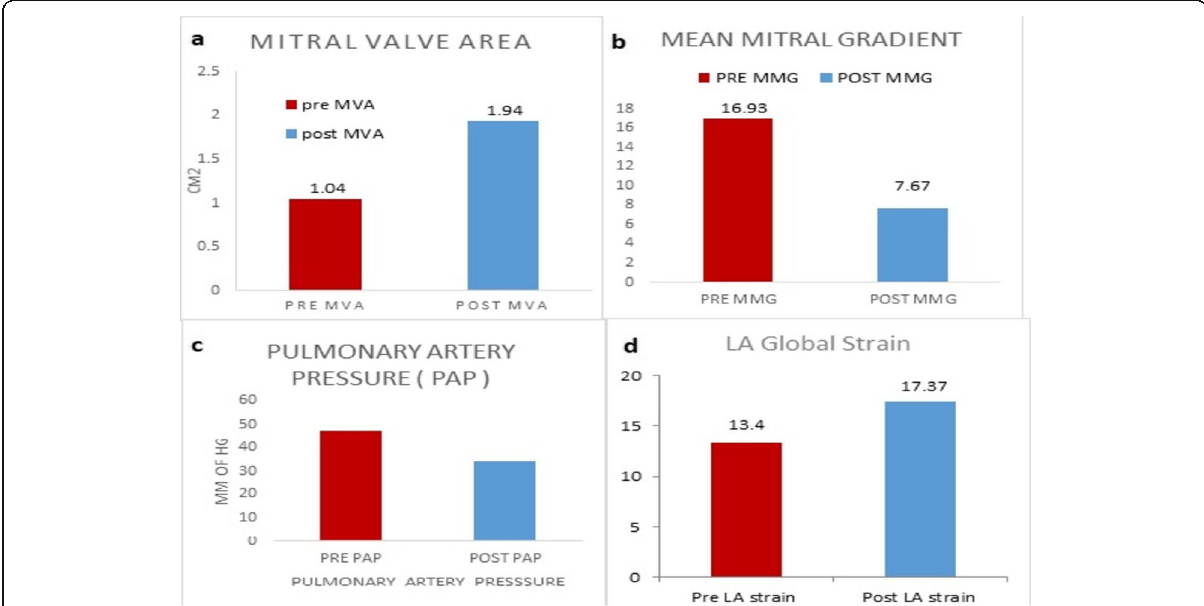
Fig. 3 Comparison of various echocardiographic parameters of pre- and post-BMV in mitral stenosis. a Mitral valve area. b Mean mitral gradient. c Pulmonary artery pressure. d LA global strain